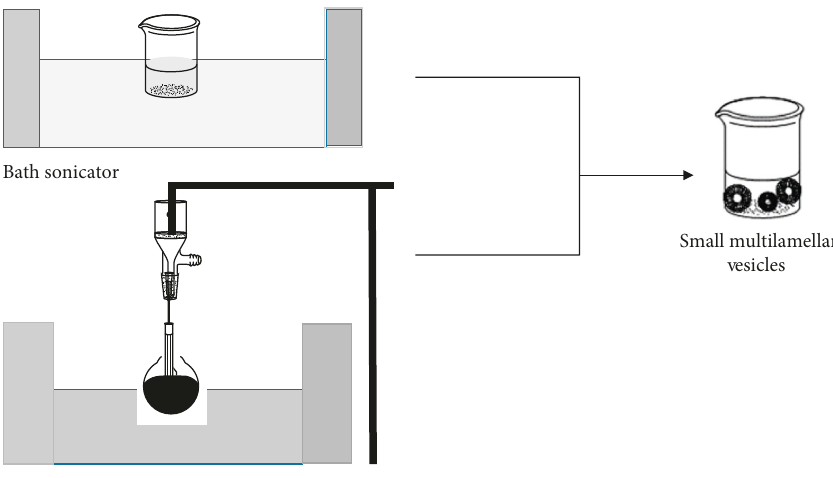
Figure 11: Schematic small unilamellar vesicles (niosomes) formation by sonication